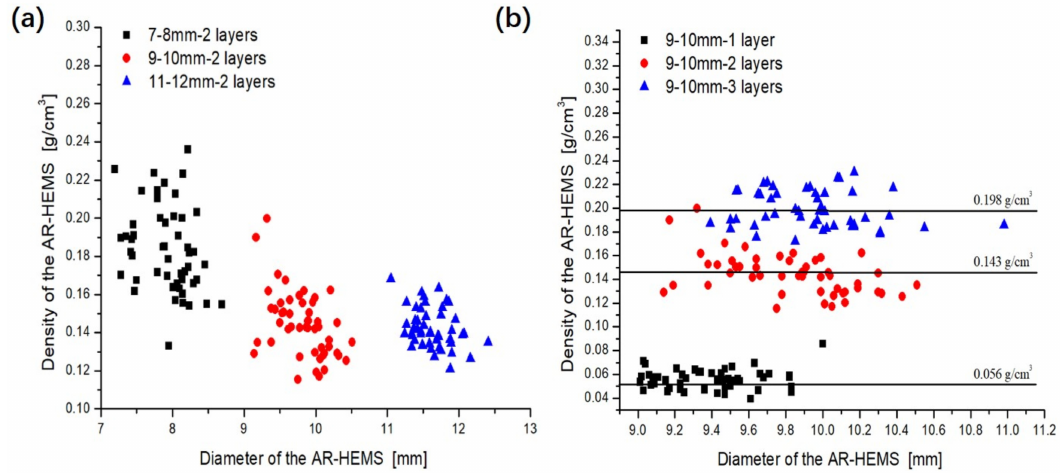
Figure 4. Scatter plot of the relationship between the diameter and density: ( a ) inner diameter is 9–10 mm and ( b ) the layer is